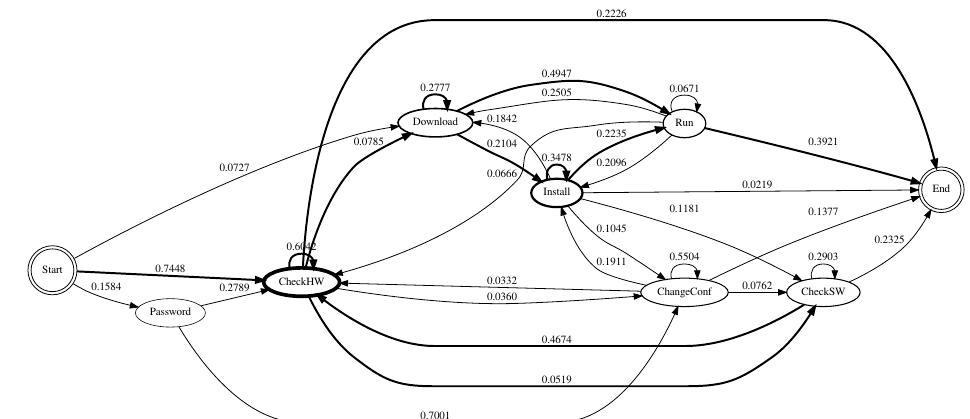
Figure 5. State diagram of the attacker’s behaviour on Asgard.